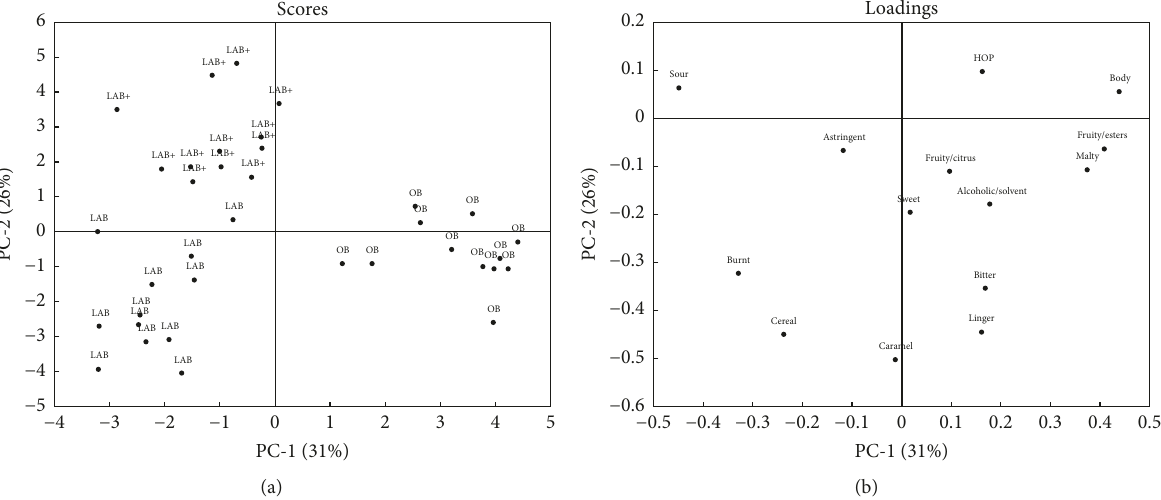
Figure 4: PCA plots of taste sensory evaluation of OB, LAB, and LAB+ samples: (a) score plot and (b) loading plot.